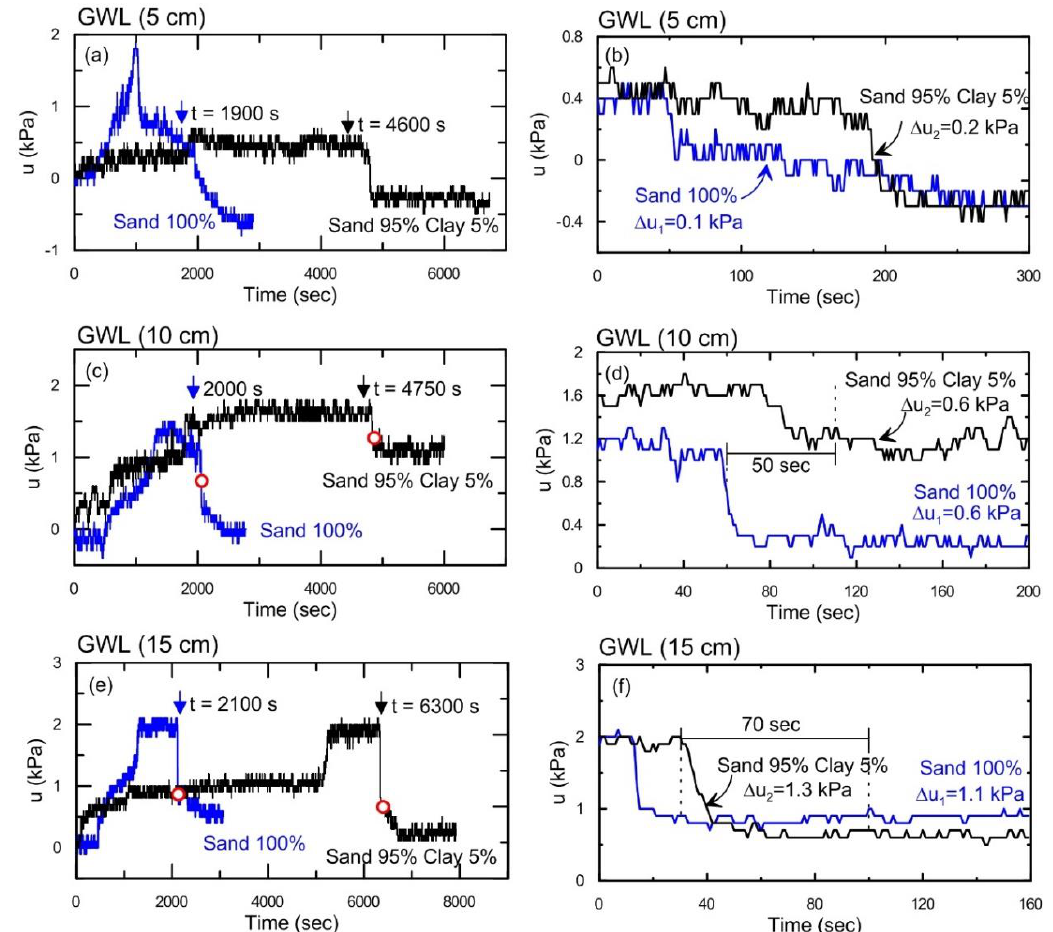
Figure 3. Comparison between the sand and sand-clay mixture results. The arrows indicate the start point of upward migration of the cavity in ( a ), ( c ), ( e ) which is the same as the time of 0 s in ( b ), ( d ), ( f ). Δu = variation in the pore water pressure (kPa).